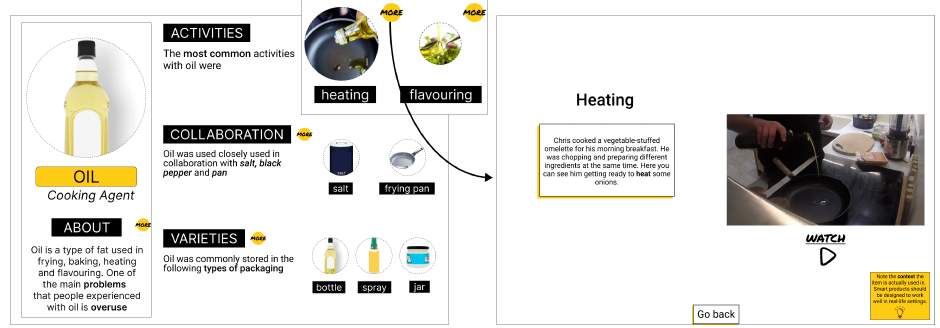
Figure 1. An example of data visualisation for the item oil . The left-side board contains all the data for the item oil . The right-side board shows the visualisation for the data on activities